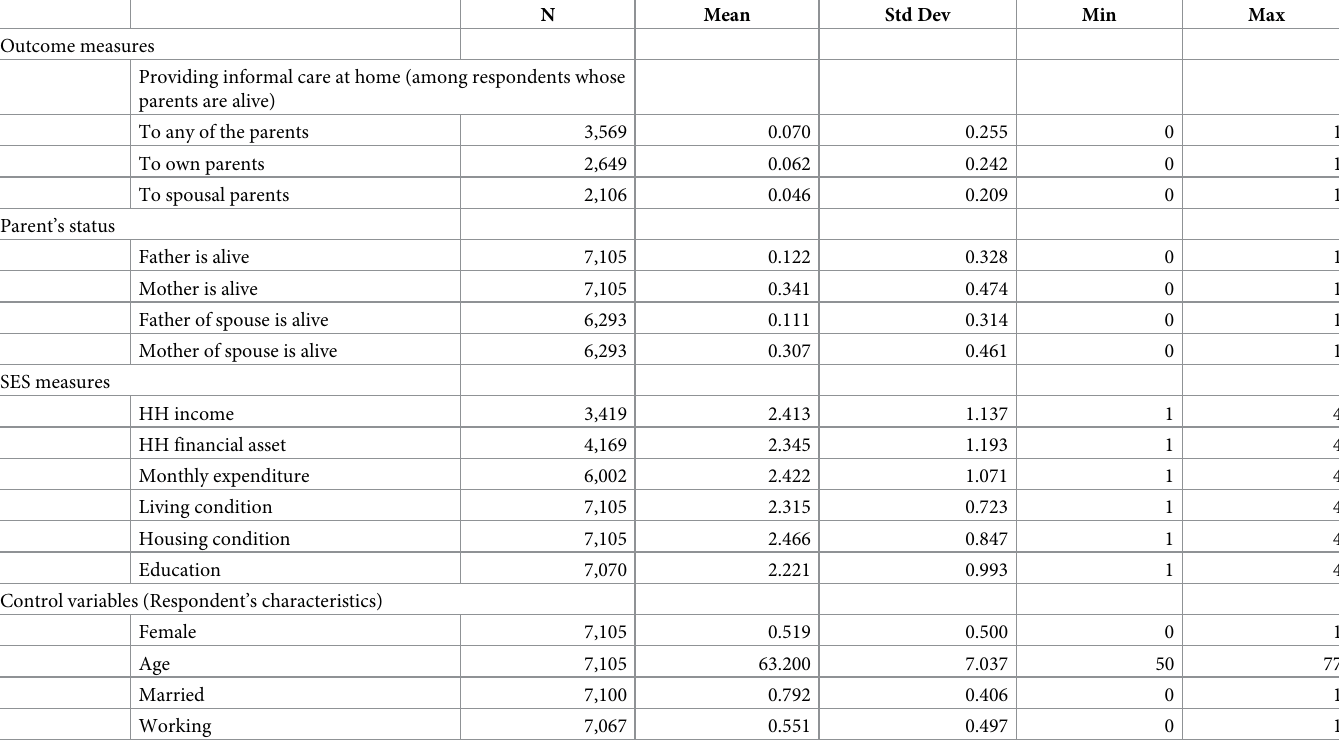
Table 1. Summary